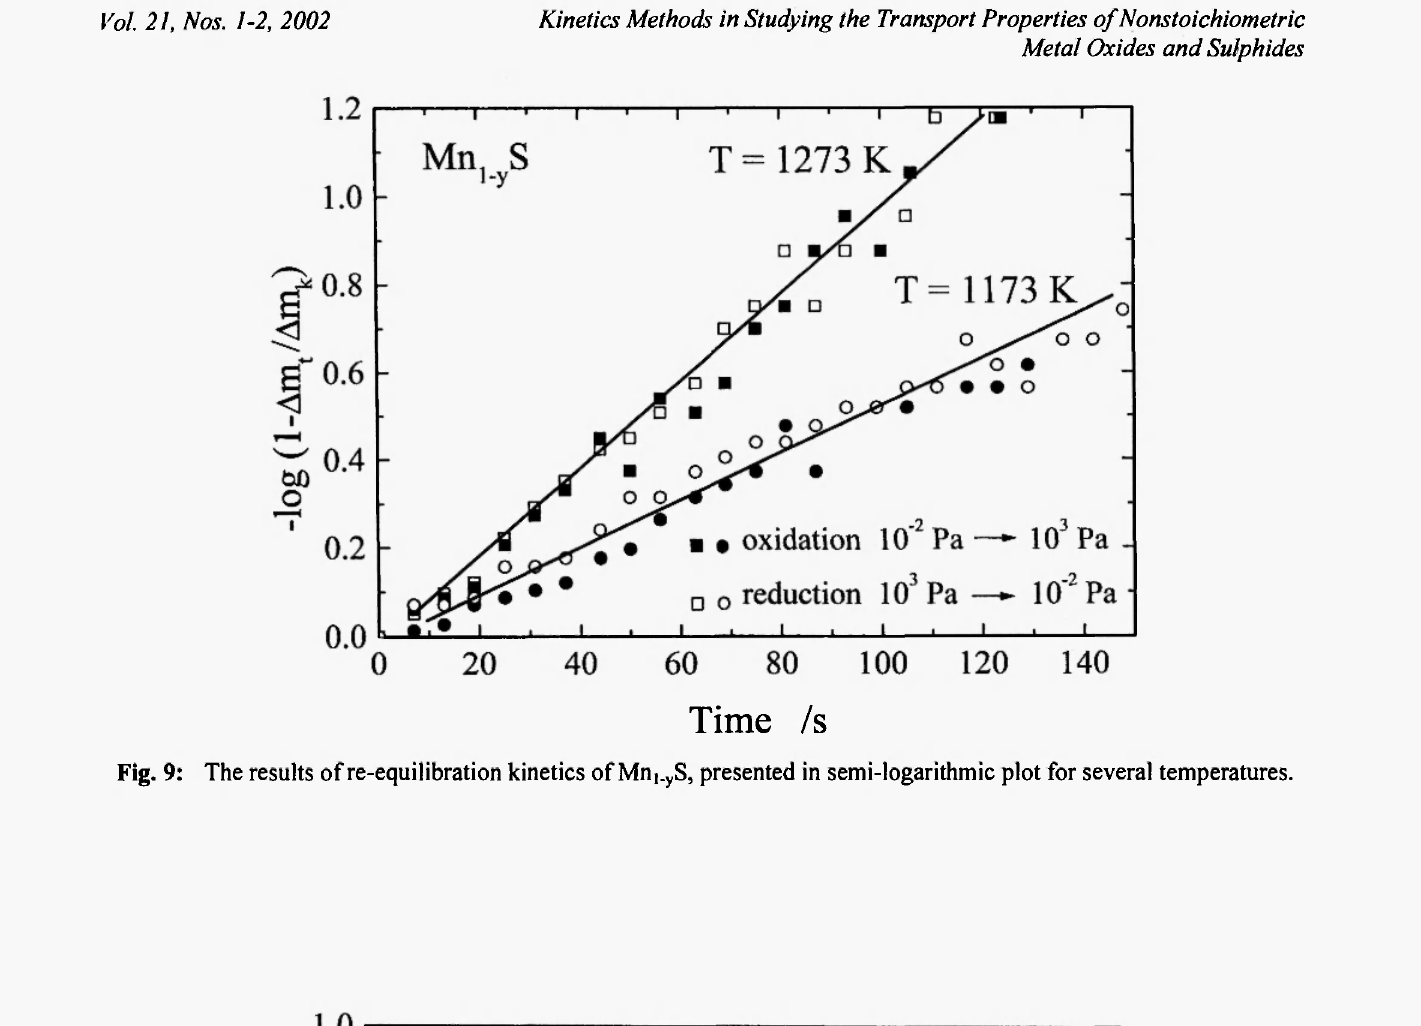
Fig. 9: The results of re-equilibration kinetics of Mn^S, presented in semi-logarithmic plot for several temperatures.